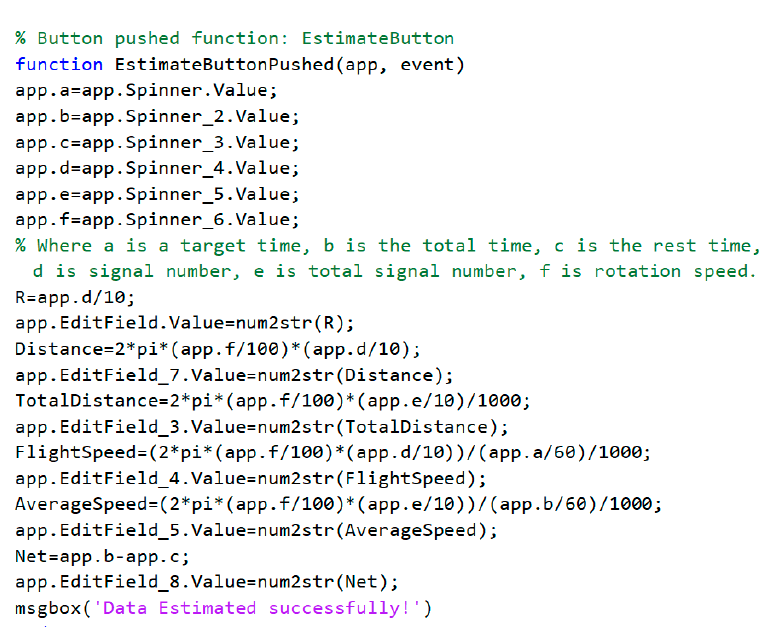
Figure 9. Flowchart of the implemented graphical user interface (GUI).